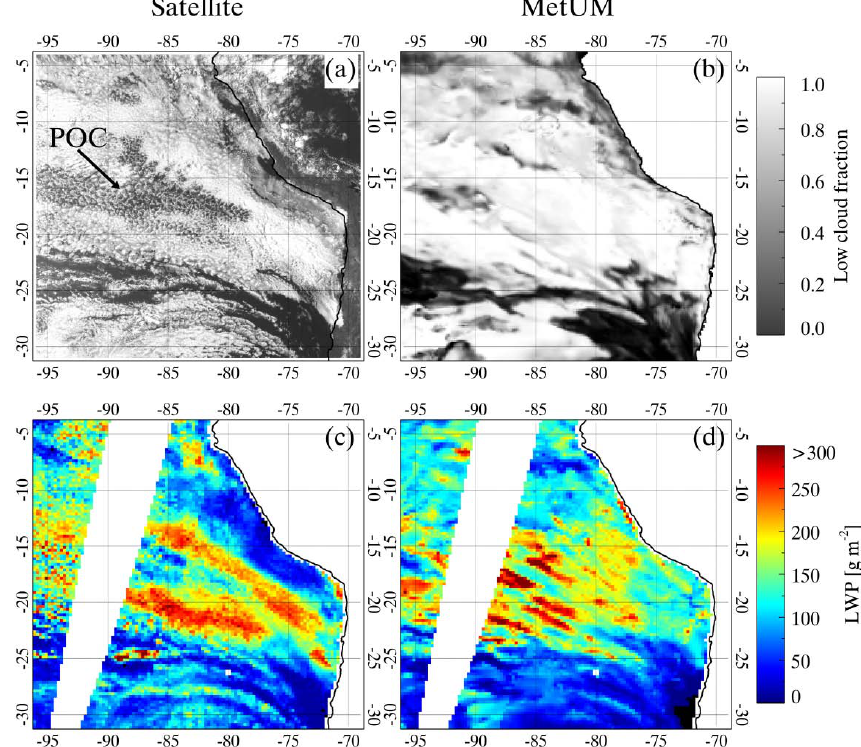
Fig. 11. An example of a POC type feature on the 28 October 2008. Panel (a) shows GOES-10 visible imagery at 12:45UTC. A composite of night time satellite LWP observations from AMSR-E, SSMI F13 and SSMI F15 is shown in panel (c) . The corresponding MetUM low cloud fraction and LWP are shown in panels (b) and (d)